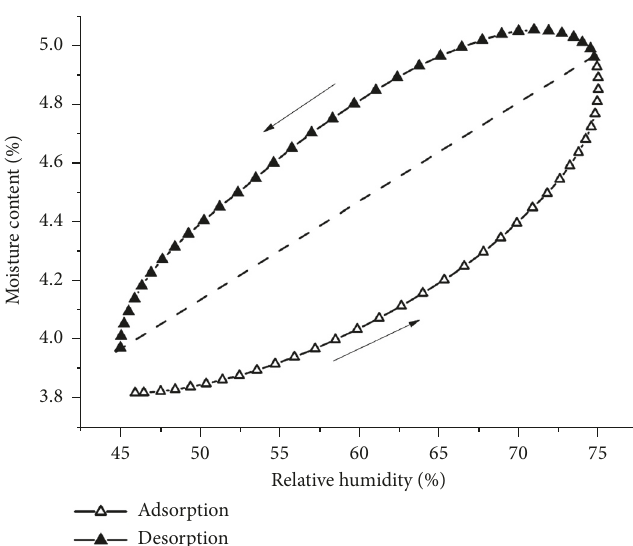
Figure 5: Plots of dynamic moisture content changes against sinusoidal relative humidity for 200 ∘ C treated